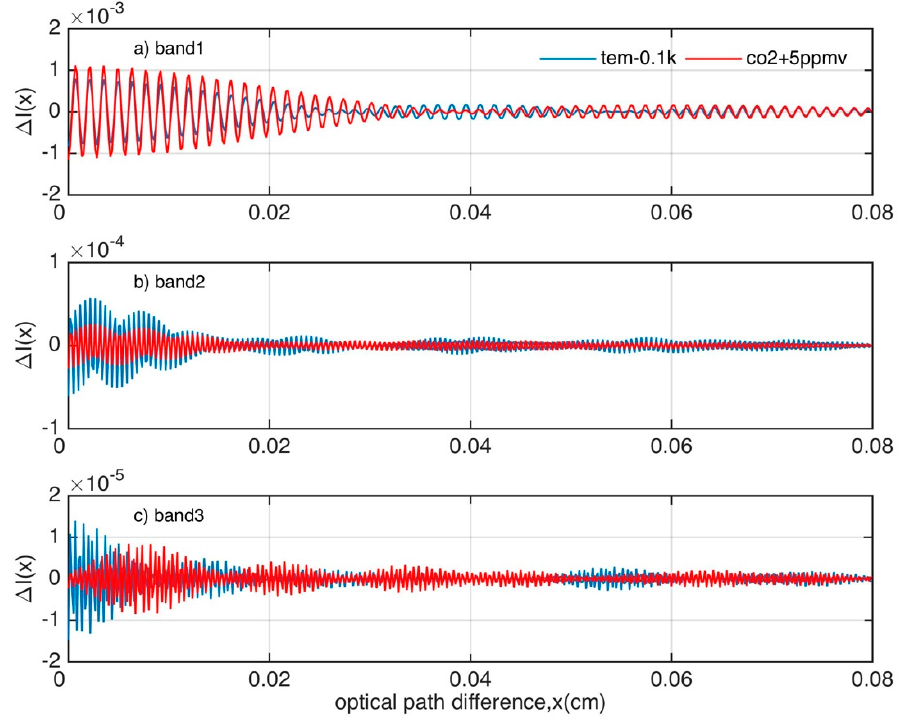
Figure 8. The ISDs caused by the temperature perturbation of 0.1 K and CO 2 perturbation of 5 ppmv, respectively. The interferograms are converted from the radiance spectra with 0.625 cm − 1 spectral resolution from ( a ) band 1 (690–725 cm − 1 ); ( b ) band 2 (2040–2100 cm − 1 ); and ( c ) band 3 (2250–2350 cm − 1 ).